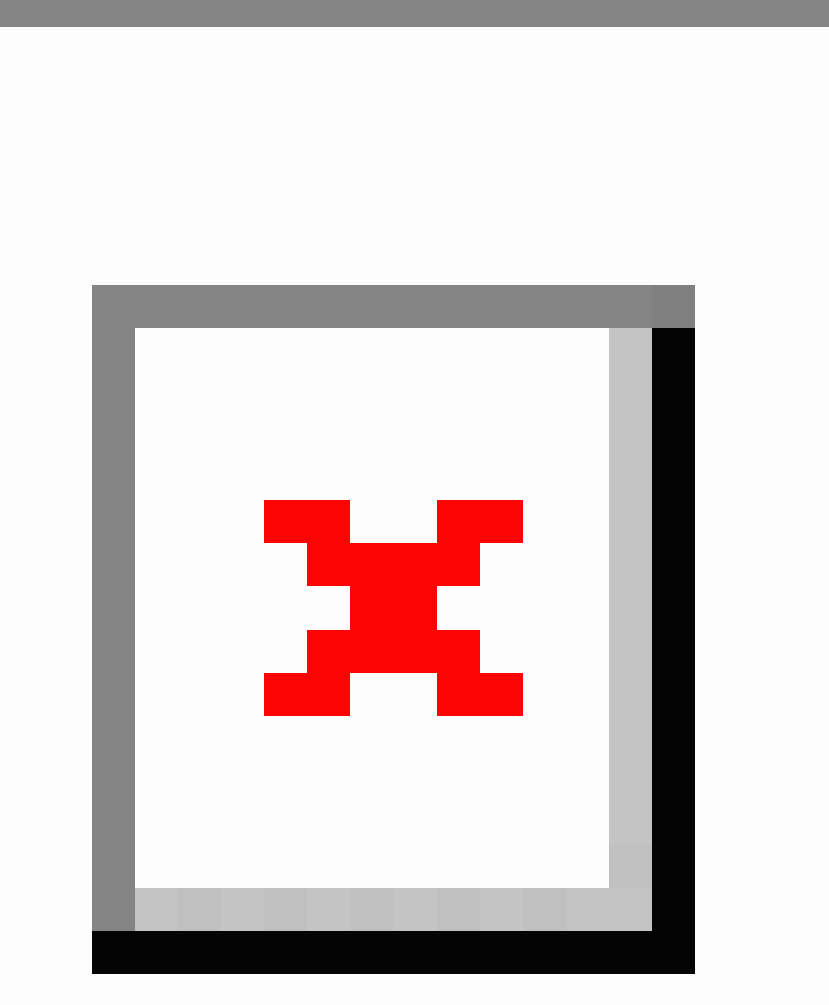
Figure 2. Mean number of dementia symptoms: instrumental activities of daily living (blue), activities of daily living (red), and behavioral and psychological symptoms (black). Given that only 5 people had a Dependance Scale score of 0 or 1, these states are combined